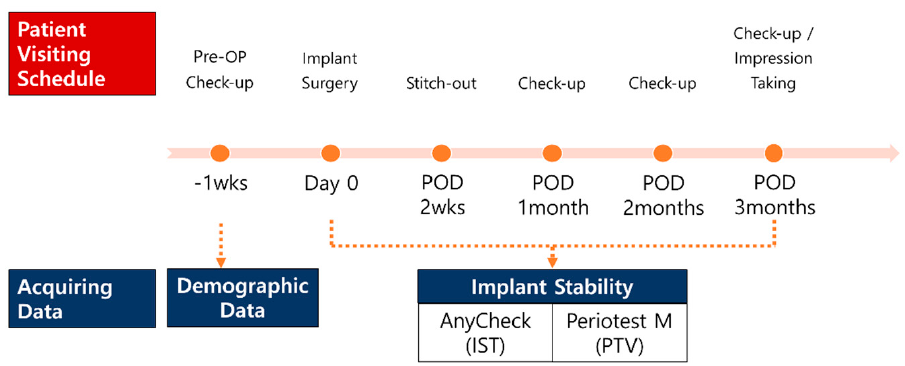
Figure 2. Schematic diagram of the clinical trials.